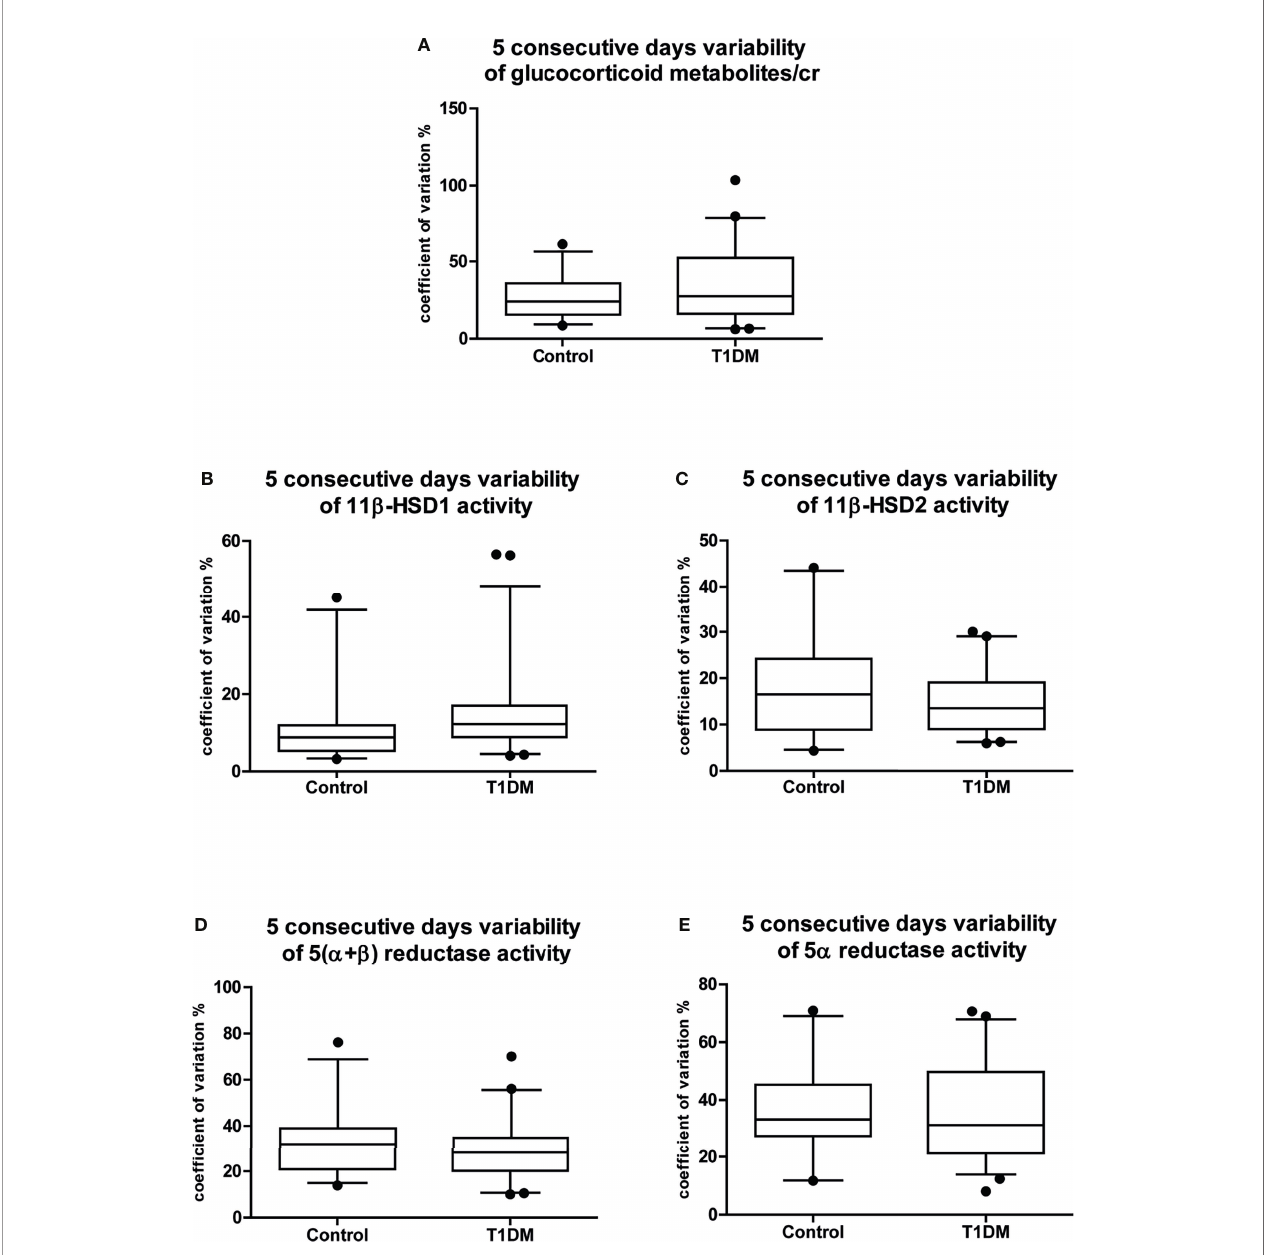
FIGURE 1 | Five consecutive days variability of the main cortisol metabolism results. Coef fi cients of variation of the 5 consecutive days variability of (A) glucocorticoid metabolites/cr; (B) 11 b -HSD1 activity; (C) 11 b -HSD2 activity; (D) 5( a + b ) reductase activity; (E) 5 a reductase activity. Data are expressed as median [25-75% percentile: plot; 5-95% percentile: whiskers]. Points below and above the whiskers are drawn as individual points. T1DM, type 1 diabetes mellitus; cr, to